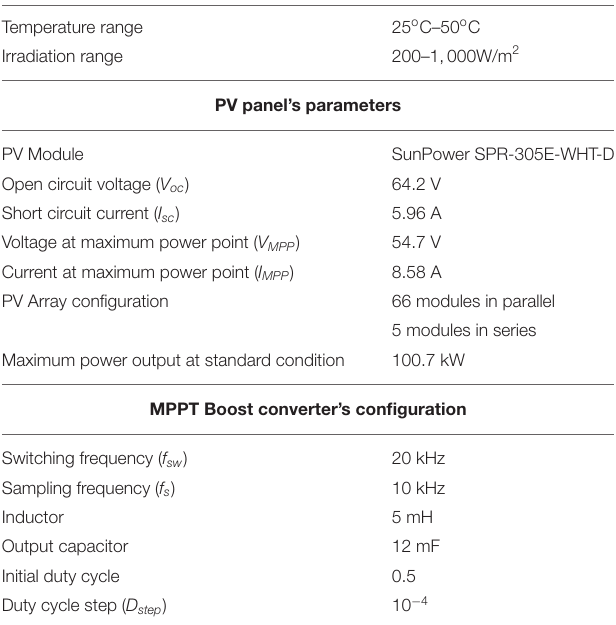
TABLE 1 | Table of simulation